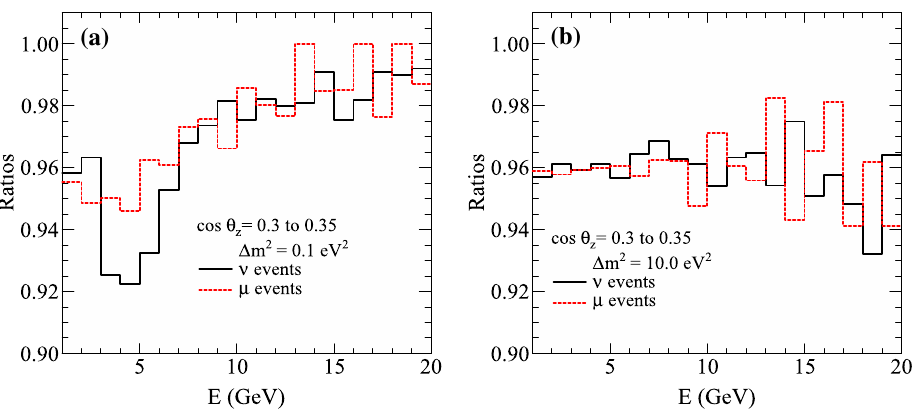
= 0.1eV 2 , b (cid:2) m 2 = 10.0eV 2 . The standard oscillation and a (cid:2) m 2 41 41 parameters are the same as in Fig. 3